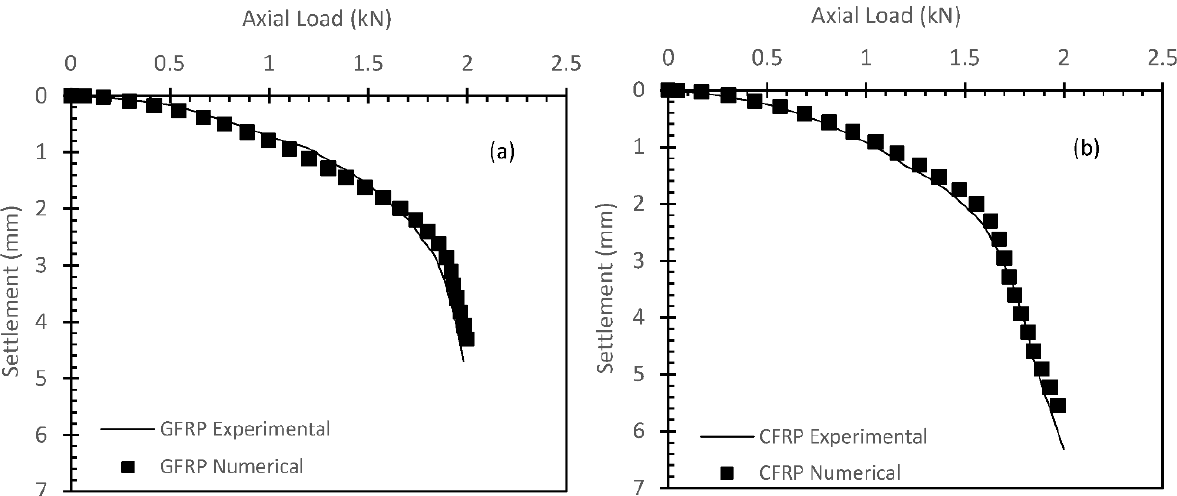
Figure 17. Validation of the axial load for the numerical and experimental results for GFRP ( a ) and CFRP ( b ).